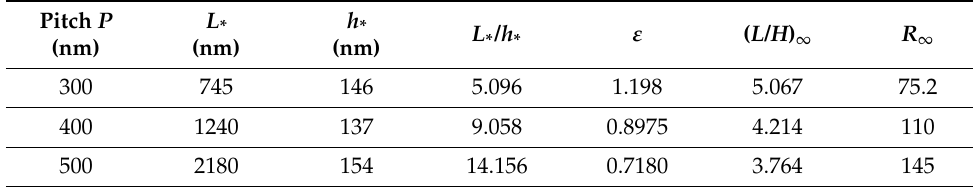
Figure 5. ( a ) NW length and ( b ) radius versus 𝐻 − 𝐻 ∗ in the case 𝐻 > 𝐻 ∗, i. e., in the growth stage where the substrate surface is entirely shadowed by the NW array, obtained from Equations (22) and (25) for different pitches shown in the legend, assuming that all NWs had the same radius of 75 nm at 𝐻 = 𝐻 ∗ . The length increases linearly with the deposition thickness at 𝑃 = 300 nm, at an almost constant radius. The length curves become more sublinear with increasing the pitch, corresponding to the larger increase of the radii. Table 2. Parameters used in Figure